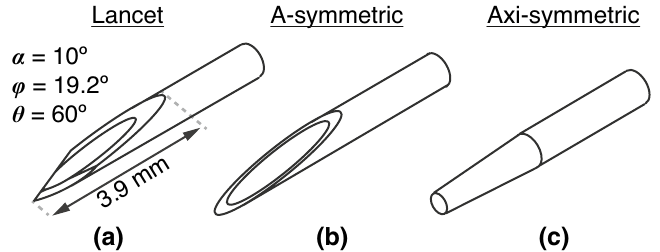
Figure 1. Different bevel geometries included in this study. ( a ) Lancet with specifications according to ISO 7864:2016 36 , where α was the primary bevel angle, θ was the secondary bevel rotation angle, and φ was the secondary bevel angle, when rotated, measured in degrees ( ◦ ). ( b ) Linear a-symmetric single step bevel (referred to as “standard” in DIN 13097:2019 37 ), and ( c ) linear axi-symmetric (circumferential) single-step bevel.